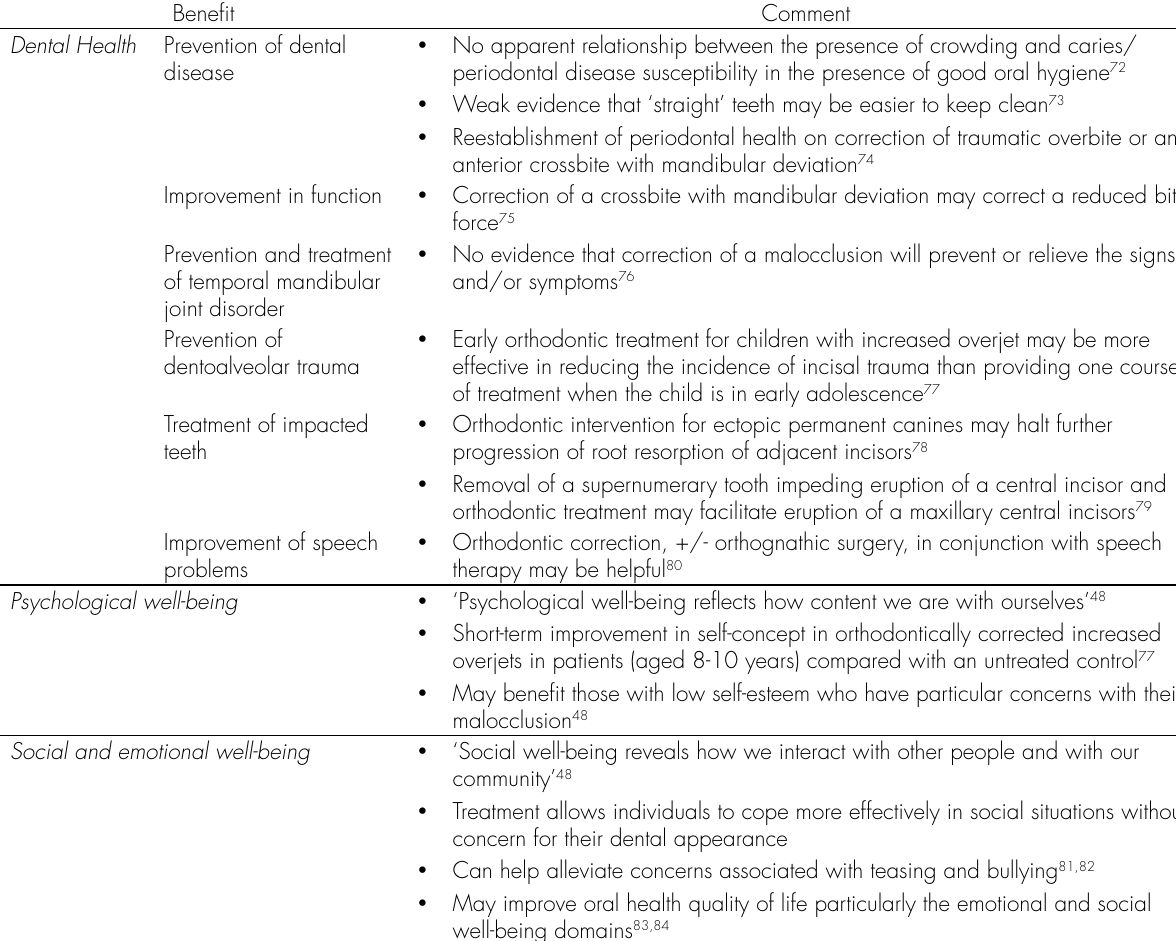
Table I. Summary of the main proposed benefits of orthodontic